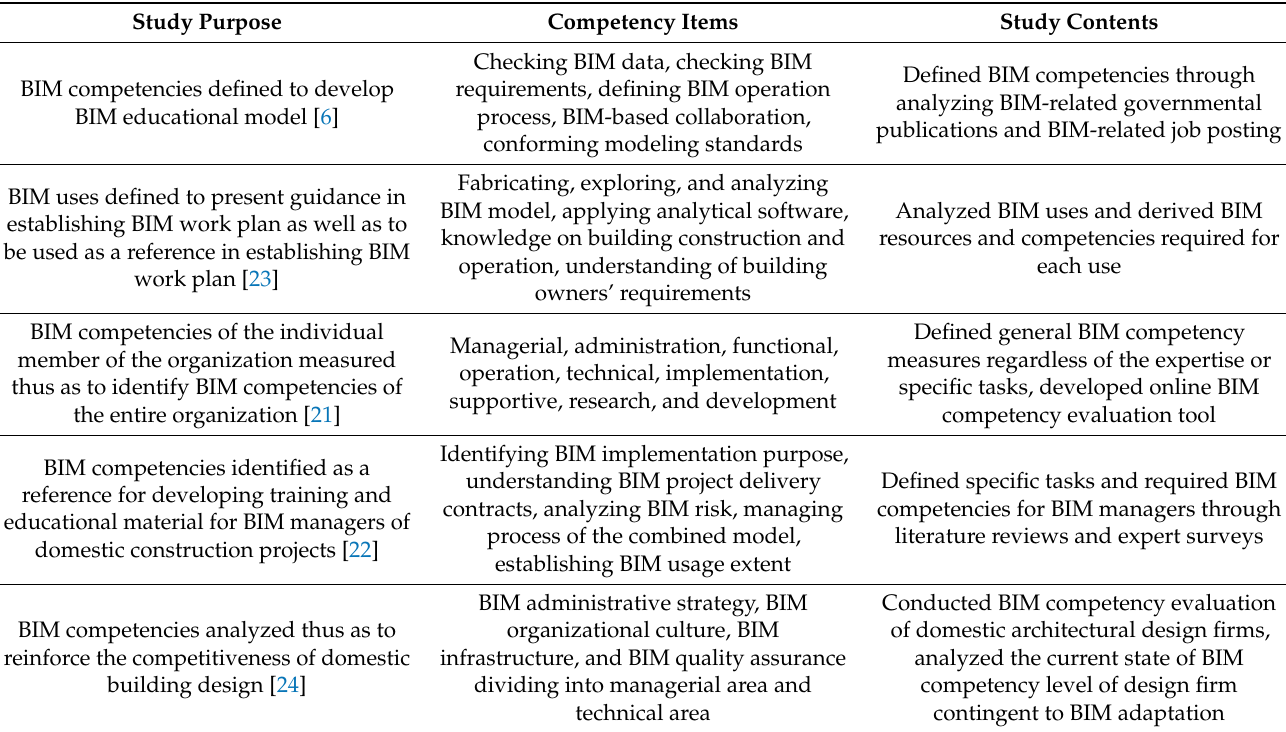
Table 1. Prior studies on defining BIM